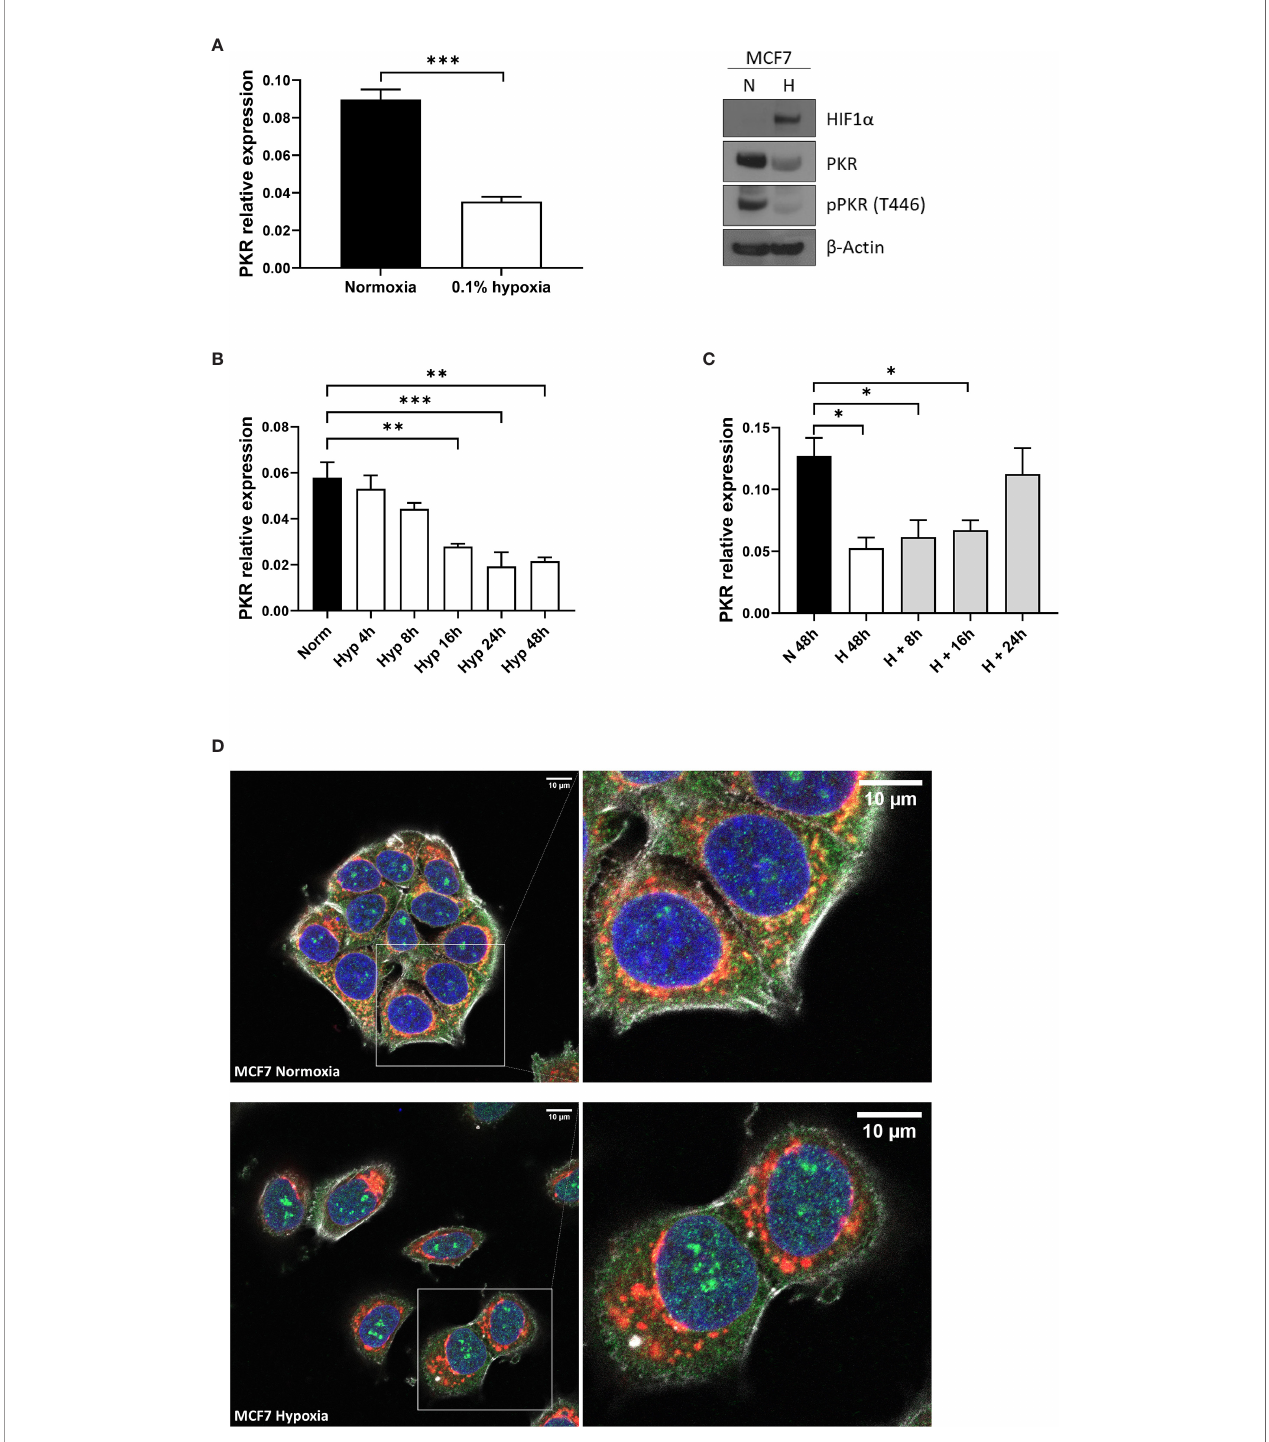
FIGURE 4 | PKR is downregulated in hypoxia. (A) PKR expression levels analysed by qPCR and western blot in MCF7 cells cultured in normoxia or 0.1% hypoxia for 48h (n=3). PKR mRNA expression was analysed in MCF7 cells cultured in normoxia or 0.1% hypoxia for 4h, 8h, 16h, 24h and 48h (n=3) (B) and in MCF7 cells cultured in 0.1% hypoxia for 48h and later reoxygenated for 8h, 16h and 24h (n=3) (C) . (D) PKR was stained using PKR antibody in MCF7 cells exposed to normoxia or 0.1% hypoxia for 48h from 3 independent replicates. Number of replicates indicate biological replicates and data is shown as mean ± SEM. *p < 0.05, **p < 0.01, ***p < 0.001. Green: PKR antibody staining, blue: DAPI and red: MitoTracker staining. Scale bars correspond to 10 m